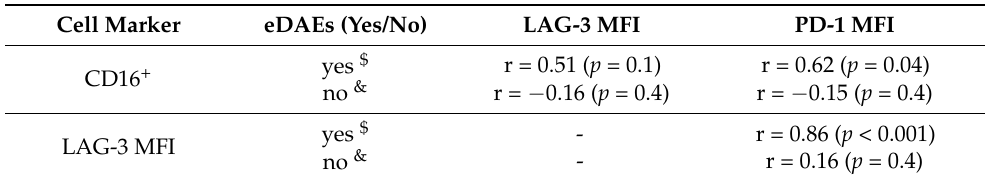
Table 4. Correlation models between CD16 positive expression, PD-1 MFI, and LAG-3 MFI